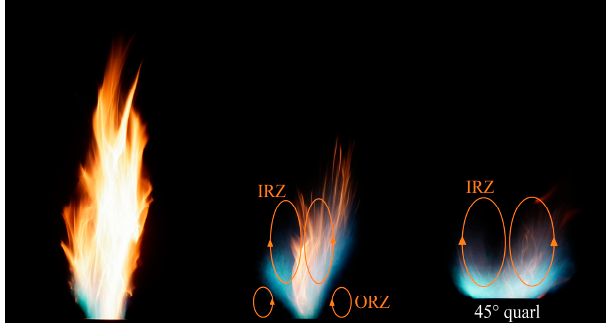
Figure 3. Straight flame at the end of the transitory regime ( left , p g = 0.3 bar, λ = 1.1, and S’ = 0.82), stable V-shaped flame ( middle , p g = 0.3 bar, λ = 1.23, and S’ = 0.91), and V-shaped flame with a 45° quarl ( right , p g = 0.3 bar, λ = 1.25, and S’ = 0.92).